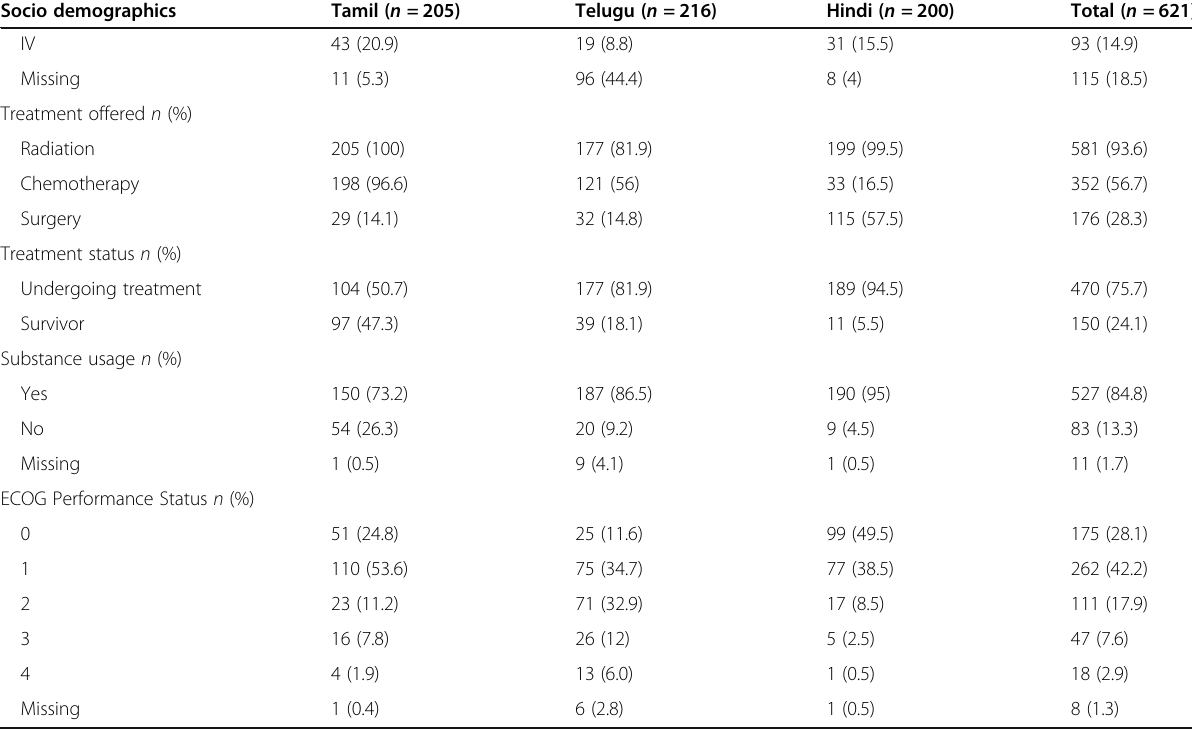
Table 1 Sociodemographic and clinical characteristics for 621 patients across languages and in total (Continued) Socio demographics